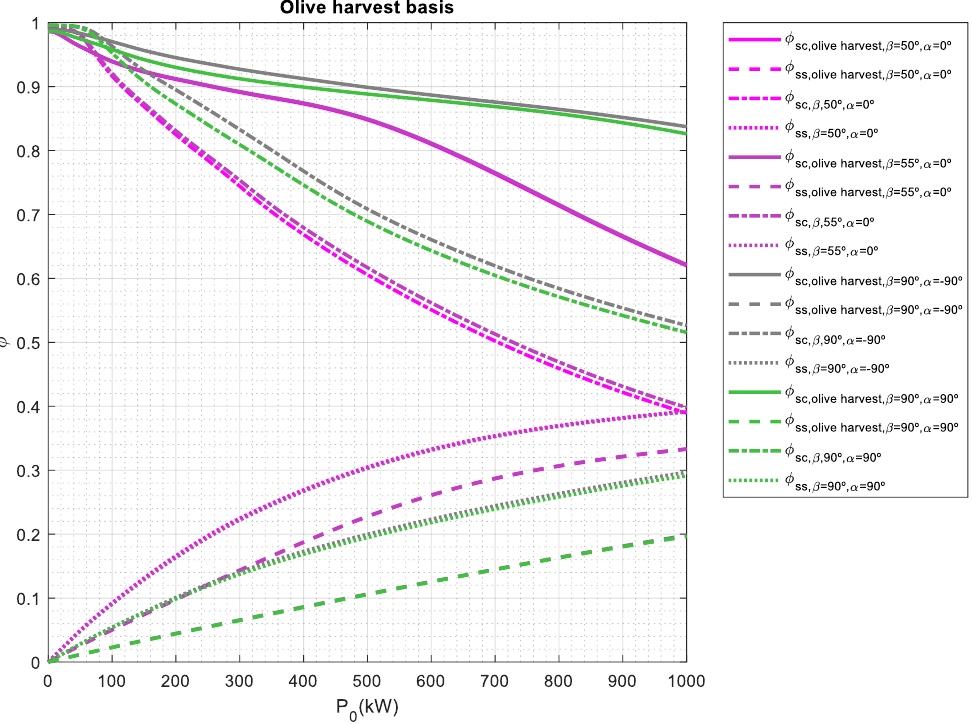
Figure 7. Olive harvest basis. Φ sc and Φ ss curves which maximizes and minimizes the Φ Figure 7 Olive harvest basis. Ф sc and Ф ss curves which maximizes and minimizes the Ф ss.